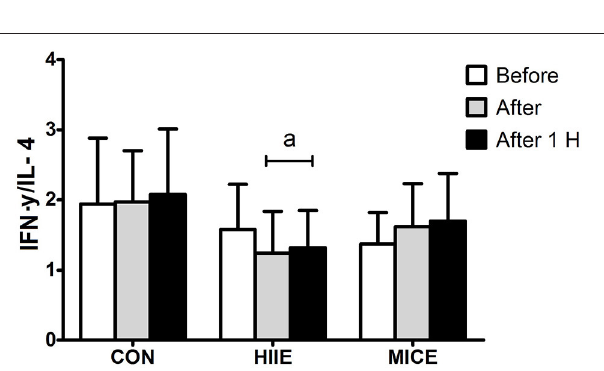
FIGURE 3 | Interferon- γ /interleukin-4 ratio before (Before), immediately after (After) and 1h after (After 1H) high intensity interval exercise (HIIE), moderate intensity continuous exercise (MICE), and control (CON) condition. Values are presented as mean ± sd. a Significant difference compared with before exercise ( P <